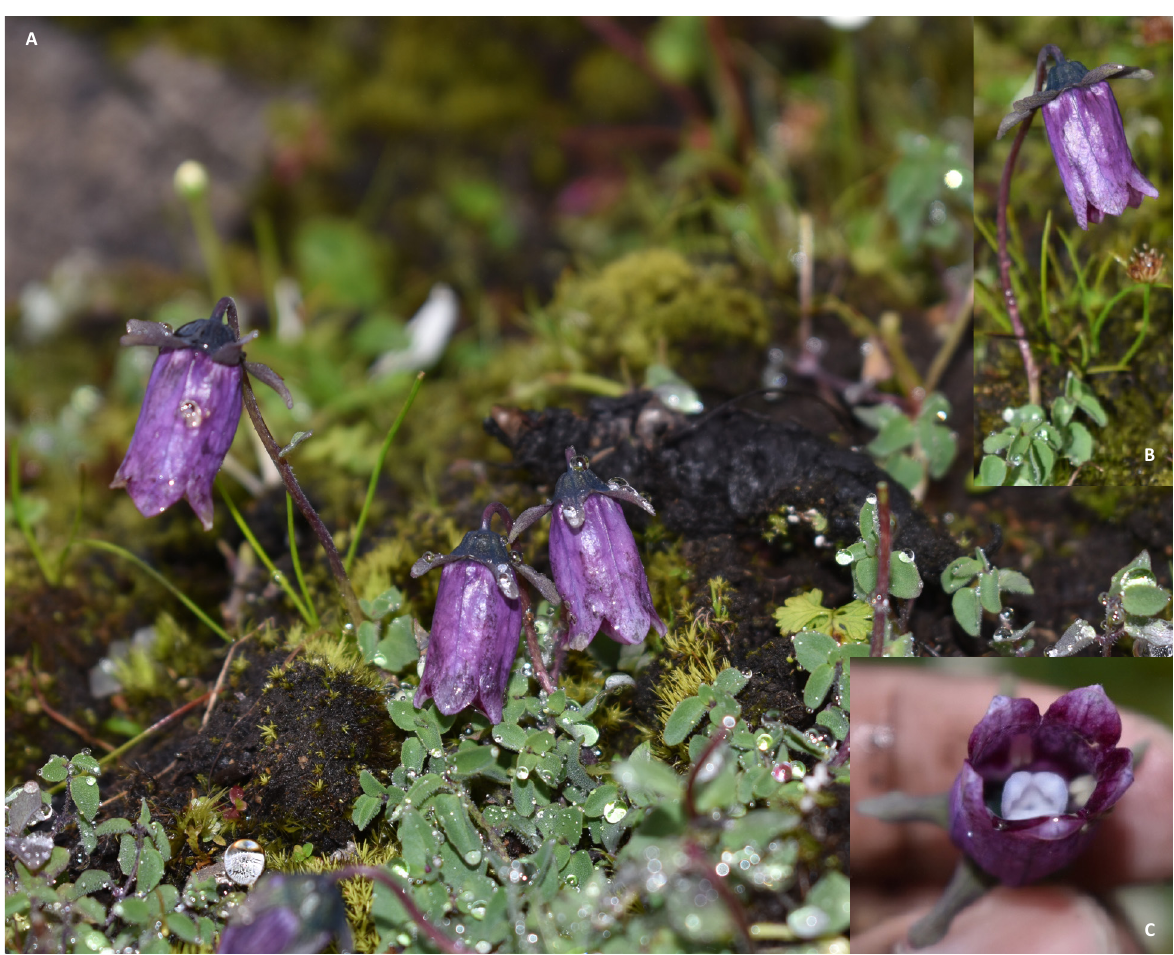
Image 2. Codonopsis thalictrifolia Wall. in Roxb.: A - Habitat | B - Habit | C - Closeup of open flower. © K.S.